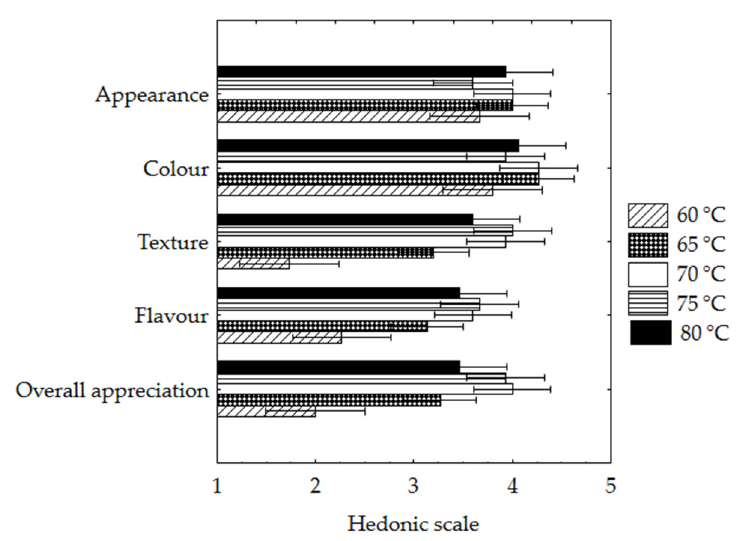
Figure 6. Sensory scores for the attributes Appearance, Color, Texture, Flavor, and Overall appreciation of dried sweet potatoes at different temperatures, 60 °, 65 °, 70 °, 75 ° and 80 °C, at 200 min.